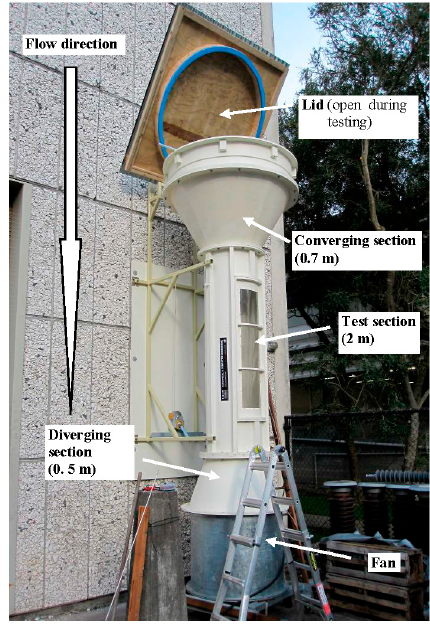
Figure 1. Customized vertical wind tunnel for Sounding Rockets.